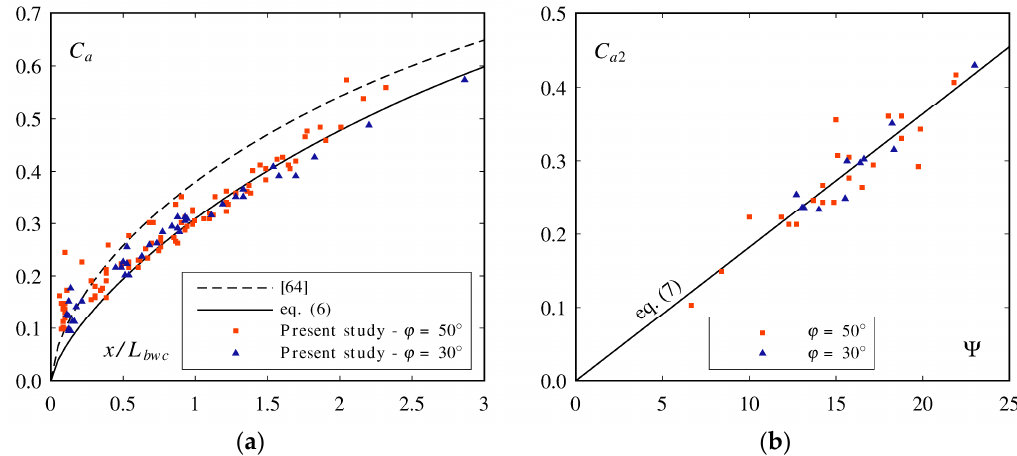
Figure 8. ( a ) Development of the average air concentration C a in the jet as a function of the streamwise position x relative to the blackwater core length L bwc . Only points upstream of the jet maximum were used ( x ≤ x 1 ); ( b ) Impact minimum average air concentration C a 2 as a function of Ψ = (1 + sin ϕ ) 1.1 · (1 + tan α ) 2.5 · F o1.1 · ( t / h o ) 0.15 .